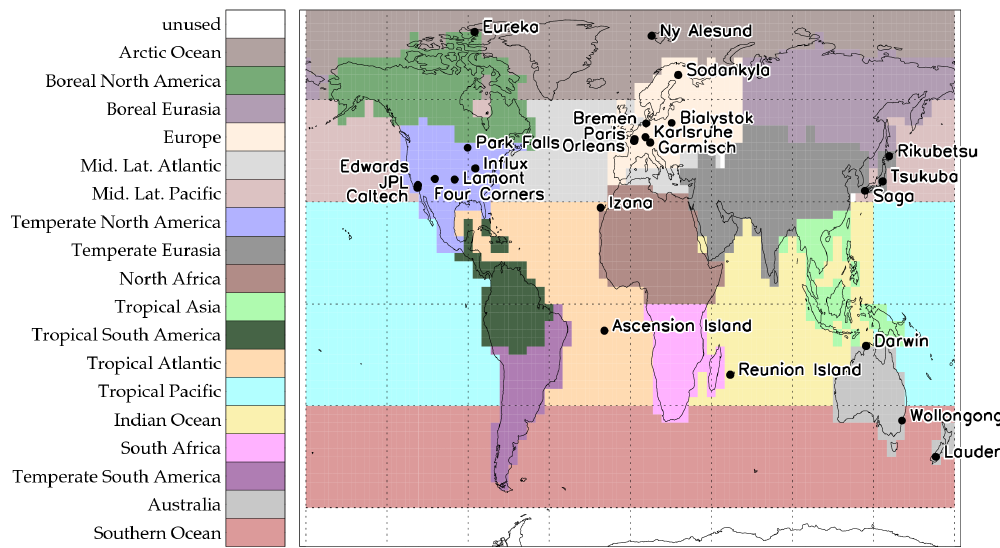
Figure 9. The regions used for comparisons with MACC and the locations of TCCON